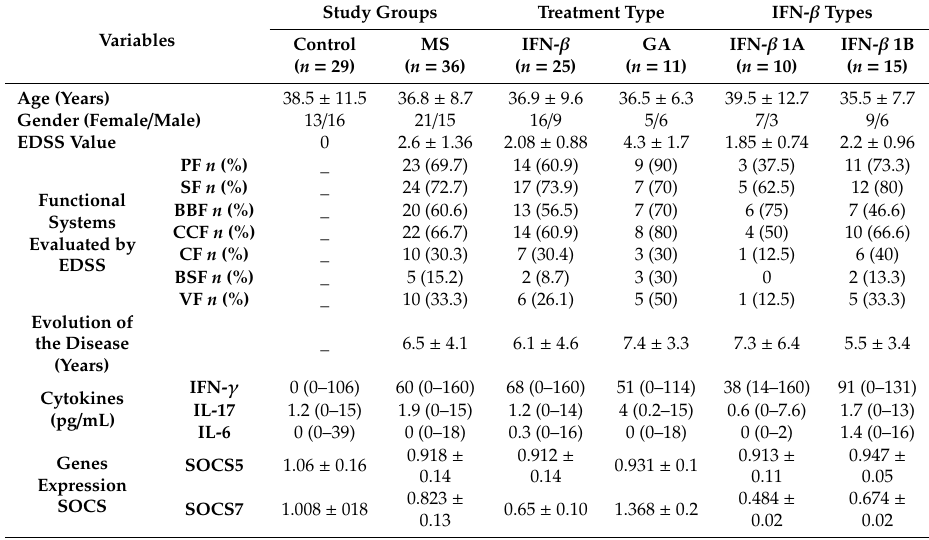
Table 1. Demographic and clinical characteristics, SOCS5 and SOCS7 transcript levels and cytokine concentrations of MS patients and healthy control